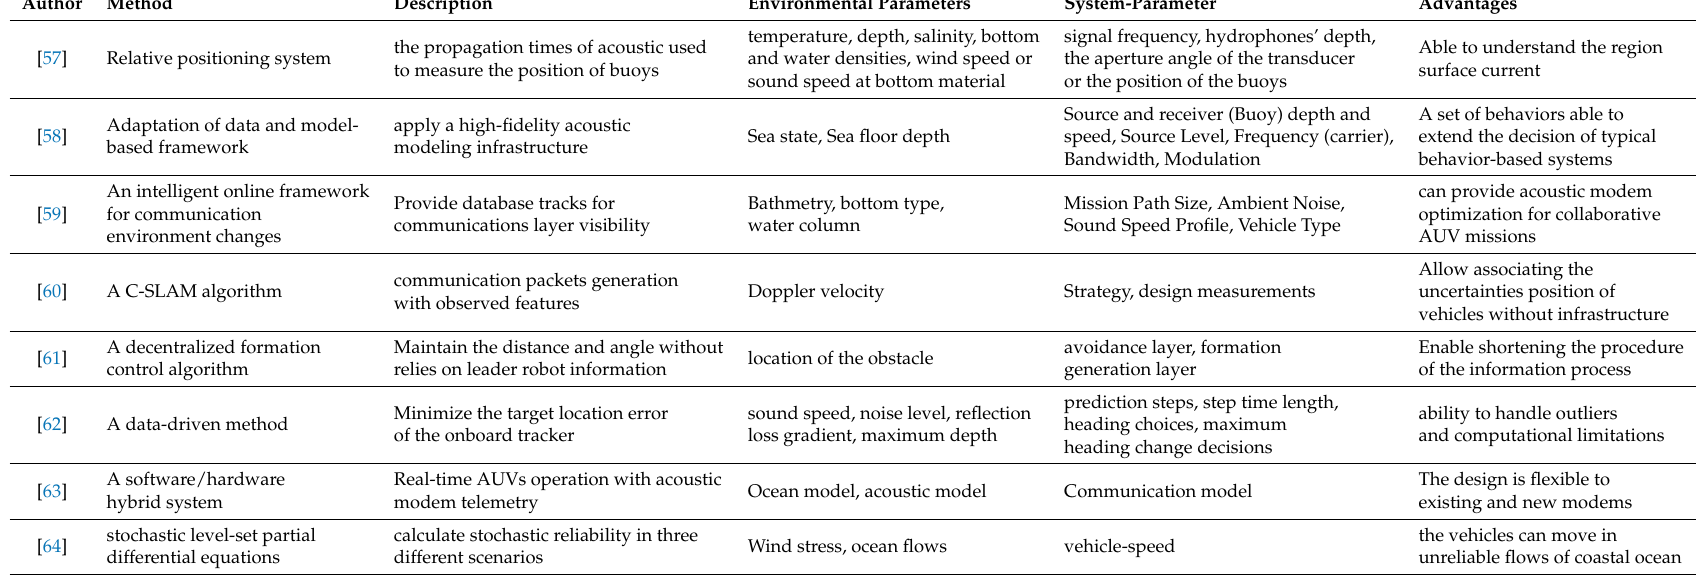
Table 4. Several Related Papers that Deal with Environmental Parameters through